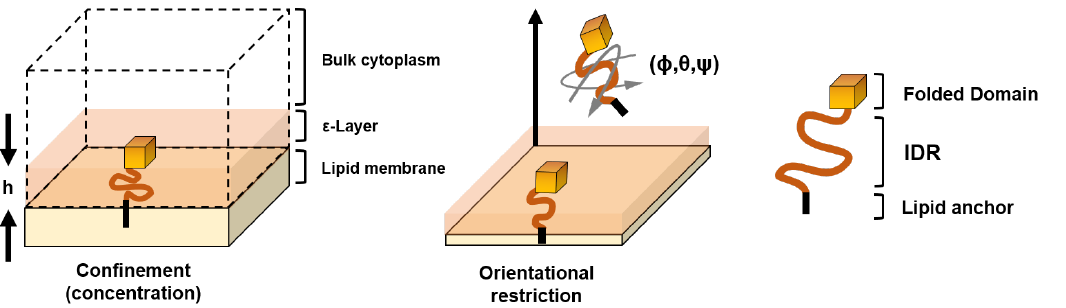
Figure 3 : Scaling from 3D to 2D. Confinement to two dimensions reduces one of the dimensions to an effective “confinement length of dimensions comparable to those of the attached IDP (left). Additional interactions (steric or electrostatic) restrict the orientation of elements capable of interactions reducing the “productive” collisions. On the other hand, the preexisting conformational restrictions decrease the entropic penalty of intermolecular complexes between confined